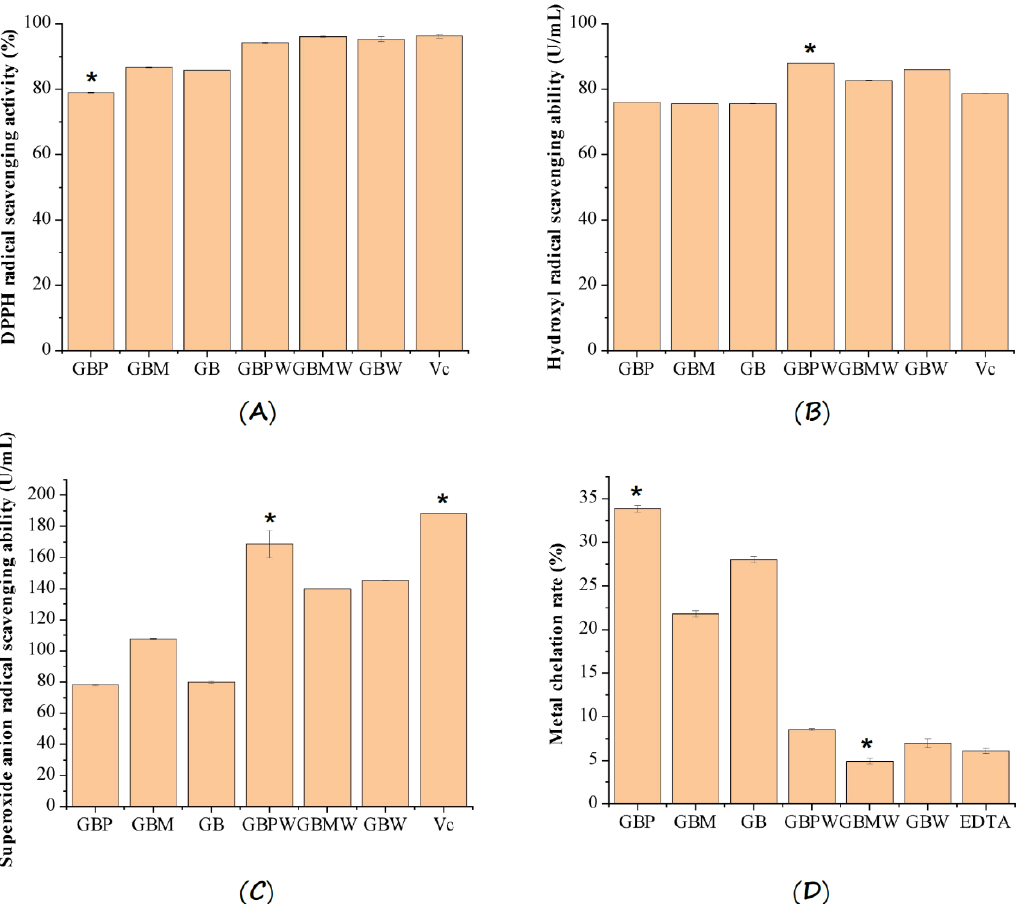
Figure 4. ( A ) DPPH radical scavenging activity, ( B ) hydroxyl radical scavenging ability, ( C ) superoxide anion radical scavenging activity, and ( D ) metal chelation rate of green banana and green banana wine samples. * denotes significant difference from other samples.